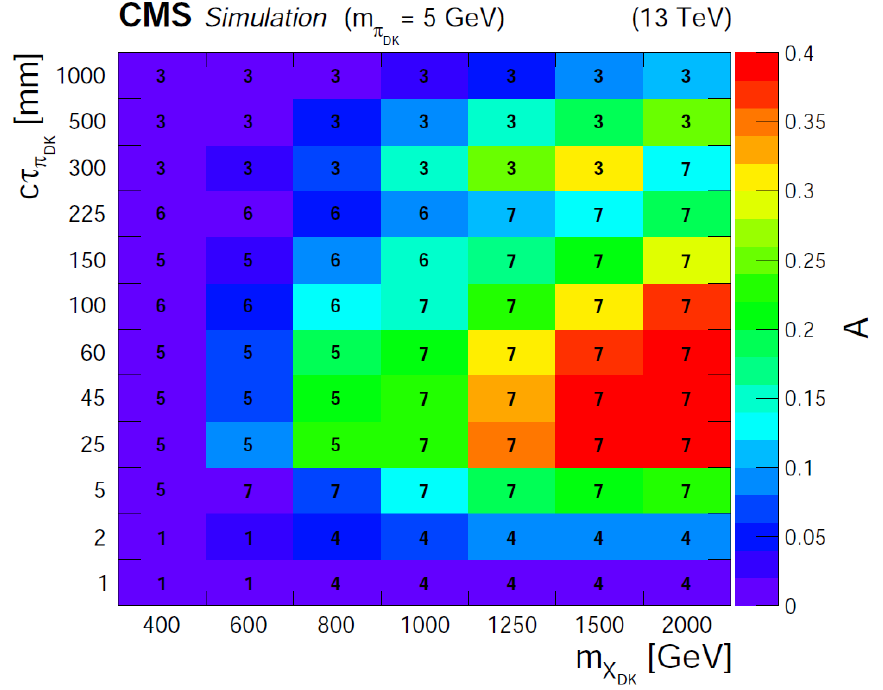
Figure 4 . The signal acceptance A, de(cid:12)ned as the fraction of simulated signal events passing the selection criteria, for models with a dark pion mass m (cid:25) mass m X and the dark pion proper decay length c(cid:28) (cid:25) DK for each model is indicated as text on the plot.